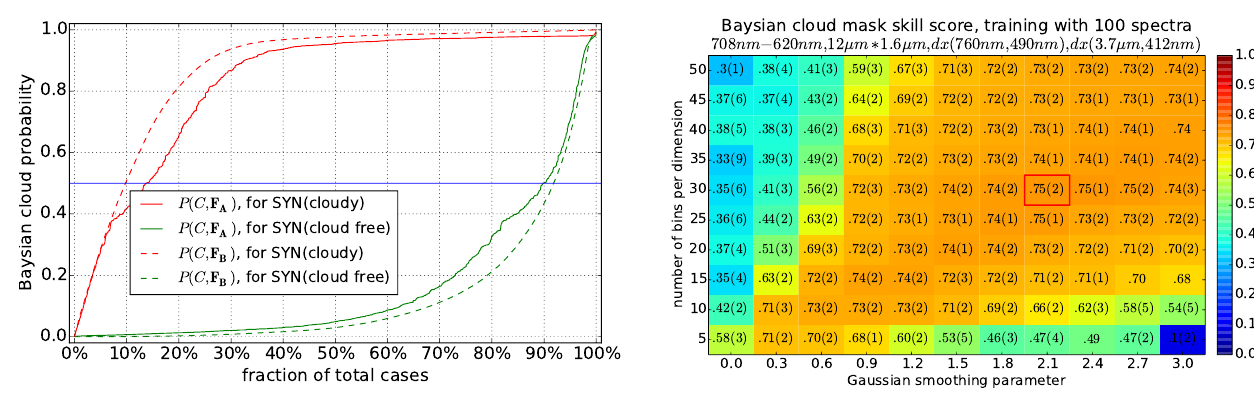
Figure 7. Cloud probability from the two classical Bayesian cloud masks from Fig. 5 (dashed line, P(C, F A ) ) and Fig. 6 (solid line, P(C, F B ) ) separated by cases which were labeled as cloudy (red) and non-cloudy (green) by the Synergy cloud mask. The same data as in Figs. 5 and 6 were used and the results were sorted for a better overview. The threshold of 0.5 cloud probability is marked with a blue line.